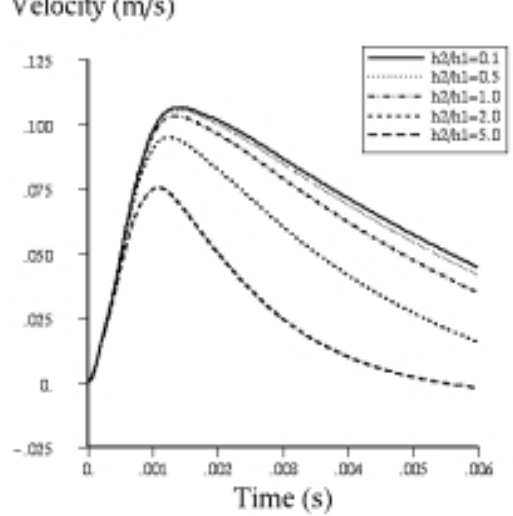
Fig. 4. Variation of central displacement with time for different thickness ratios.